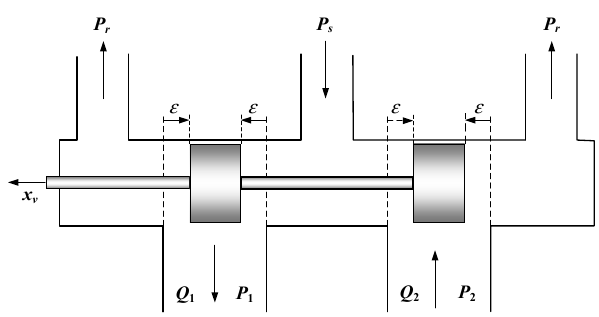
Figure 2. The schematic diagram of the flow of the proportional valve.